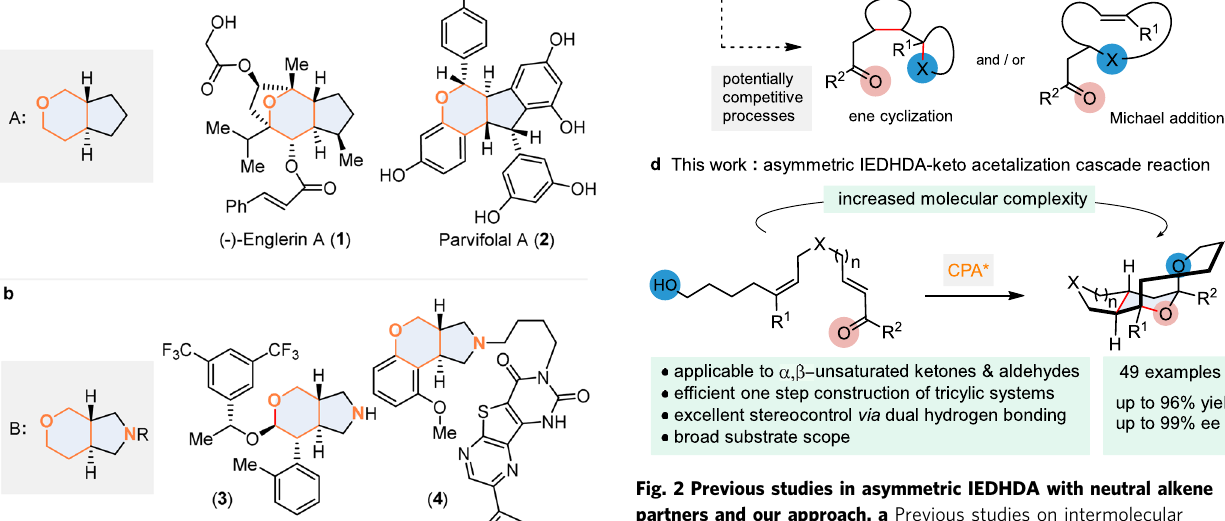
Fig. 2 Previous studies in asymmetric IEDHDA with neutral alkene partners and our approach. a Previous studies on intermolecular asymmetric IEDHDA reactions. b Previous studies on intramolecular asymmetric IEDHDA reactions. c Our approach to asymmetric intramolecular IEDHDA via dual hydrogen bonding interaction. d Access to tricyclic tetrahydropyran derivatives by chiral phosphoric acid catalyzed intramolecular IEDHDA reaction.